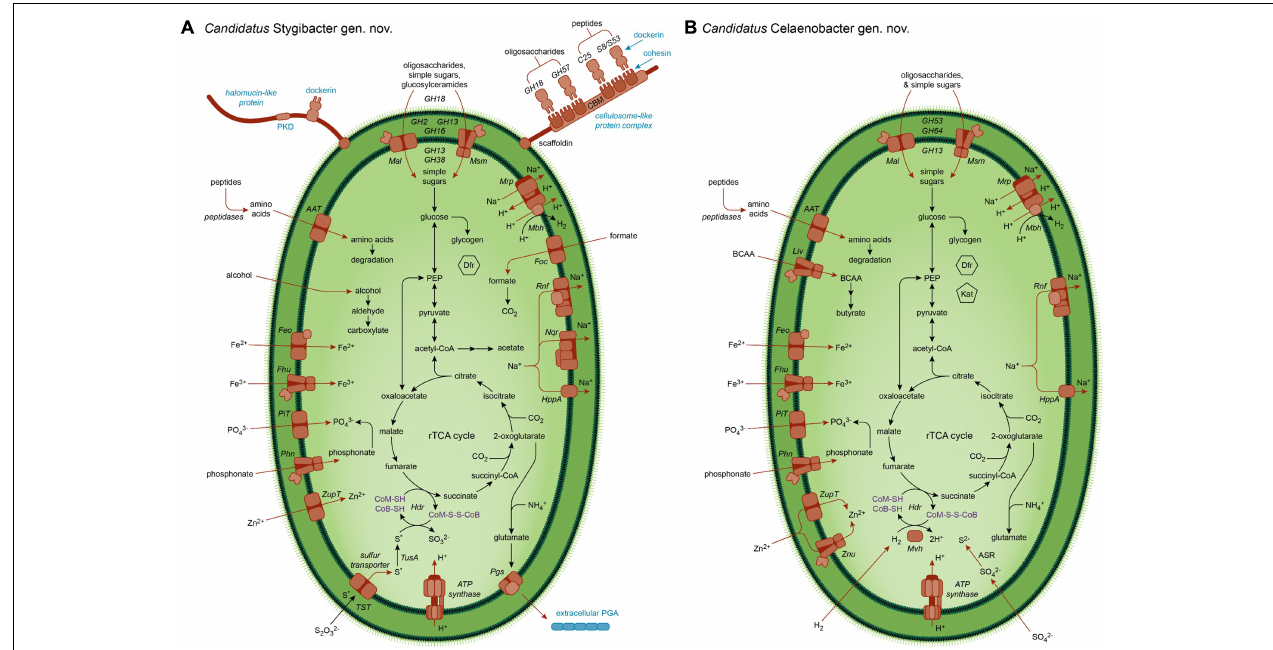
FIGURE 3 | Metabolic capacity of Cloacimonadota. Metabolic capacities inferred from MAGs for (A) Candidatus Stygibacter and (B) Candidatus Celaenobacter. AAT, amino acid transporter; ABC, ATP-binding cassette transport system; BCAA, branched-chain amino acids; CoB-SH, coenzyme B; CoM-SH, coenzyme M; CoM-S-S-CoB, heterodisulfide; Dfr, desulfoferrodoxin; Feo, ferrous iron transporter; Fhu iron ABC transporter; Foc, formate transporter; GH, glycoside hydrolase; Hdr, heterodisulfide reductase; HppA, pyrophosphate-energized sodium pump; Mal, maltooligosaccharide transport system (permease + solute-binding protein); Kat, catalase; Liv, branched-chain amino acid ABC transporter; Mbh, membrane-bound [NiFe] hydrogenase; Mrp, multicomponent Na + :H + antiporter; Msm, multiple sugar ABC transporter; Mvh, cytoplasmic [NiFe] hydrogenase; Nqr, sodium-translocating NADH:quinone oxidoreductase; PEP, phosphoenolpyruvate; PGA, poly- γ -glutamate; Pgs, poly- γ -glutamate synthase; Phn, phosphonate ABC transporter; PiT, inorganic phosphate transporter; PKD, Polycystic Kidney Disease domain (implicated in adhesion); Rnf, ferredoxin:NAD + -oxidoreductase complex; rTCA cycle, reverse tricarboxylic acid cycle; S*, unknown sulfur species; TST, thiosulfate:sulfurtransferase (rhodanese-like) (periplasmic); Znu, zinc ABC transporter; ZupT, zinc transporter. Note that the precise sulfur oxidation pathway for (B) is speculative; thiosulfate is shown here as the source of reductant, but the identity of the sulfur species is